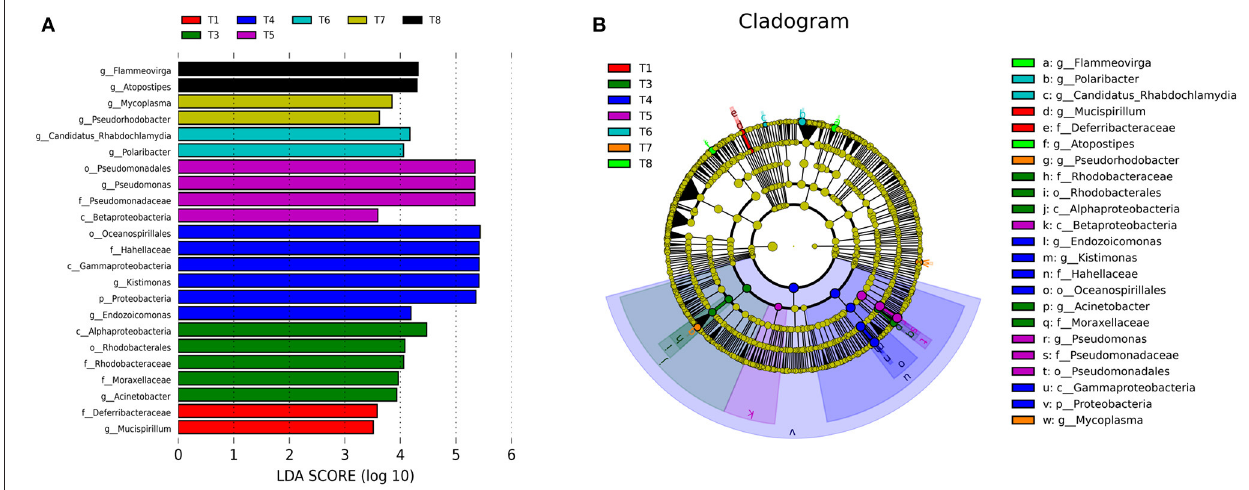
FIGURE 3 | (A) Showing LEfSe analysis of gut microbiota of various experimental groups of mussels Mytilus coruscus . Bar chart showing the log transformed LDA scores of bacterial taxa identified by LEfSe analysis. (B) Cladogram represents the phylogenetic relationships of bacterial taxa revealed by LEfSe. [T1 (DO 6mg L − 1 ×